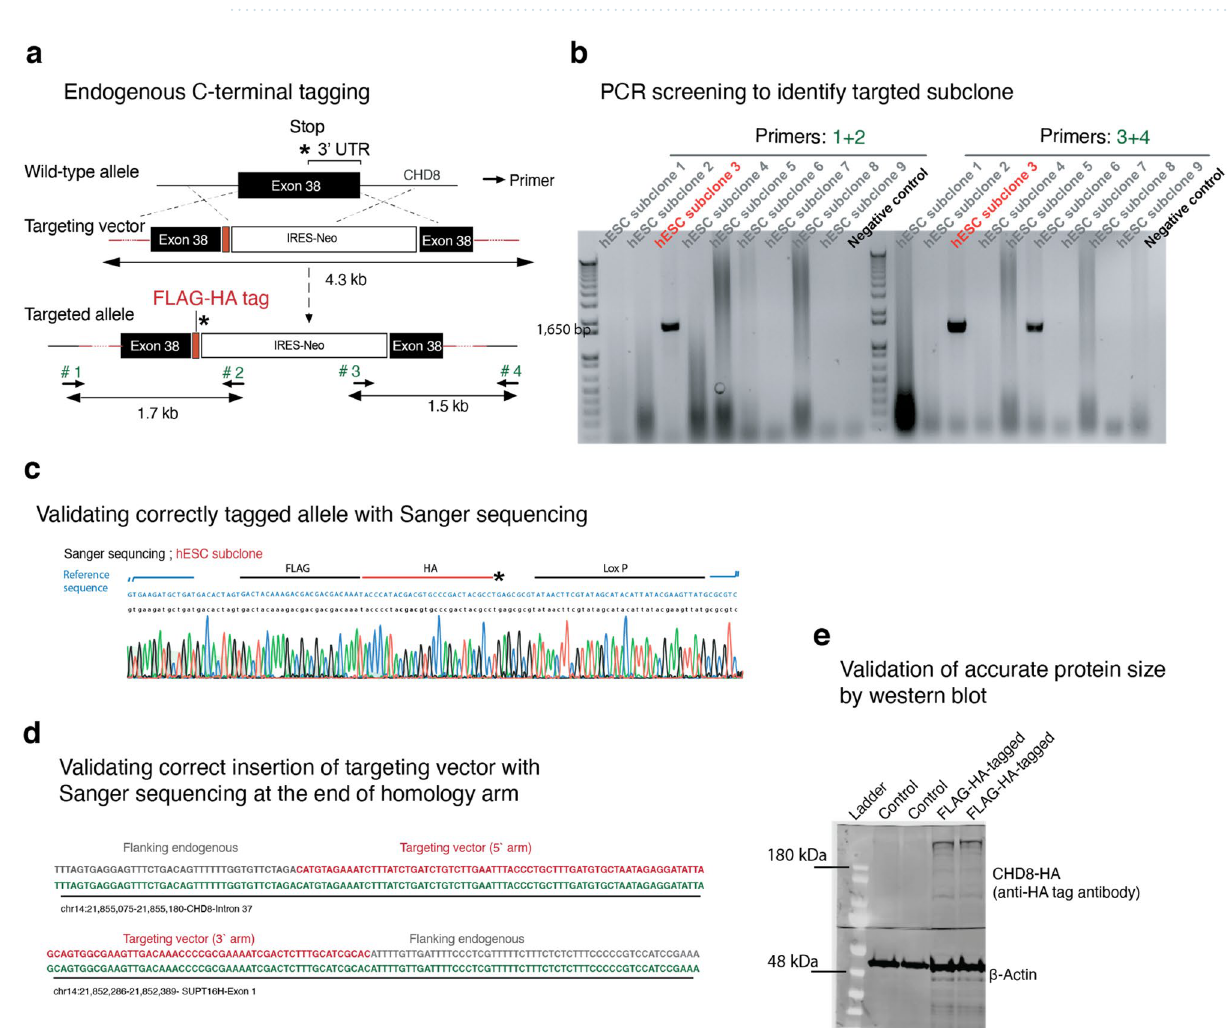
Figure 9. FLAG-HA tagging of endogenous CHD8 protein. ( a ) Schematic shows targeting strategy for in-frame insertion of FLAG-HA tag at the C-terminus region of CHD8 gene (similar to Fig. 11a with inclusion of the ‘screening’ primers). Throughout the manuscript, we have used the HA tag for downstream experiments. ( b ) Screening PCR from Neomycin resistant hESC colonies with external primers, i.e., one primer outside of the homology arms and one primer inside the targeting vector (primer #1 and #4). ( c ) Sanger sequencing to detect a correct insertion of donor vector in the C-terminus of CHD8 gene within its frame and before the STOP (*) codon. ( d ) Sanger sequencing to validate the correct transition of targeting vector into endogenous arms (black line after the blue lines on both sides). ( e ) Western blotting reveals correct protein size for HA-tagged CHD8 protein (The blot is indeed the full-length version of the same blot shown in Fig.